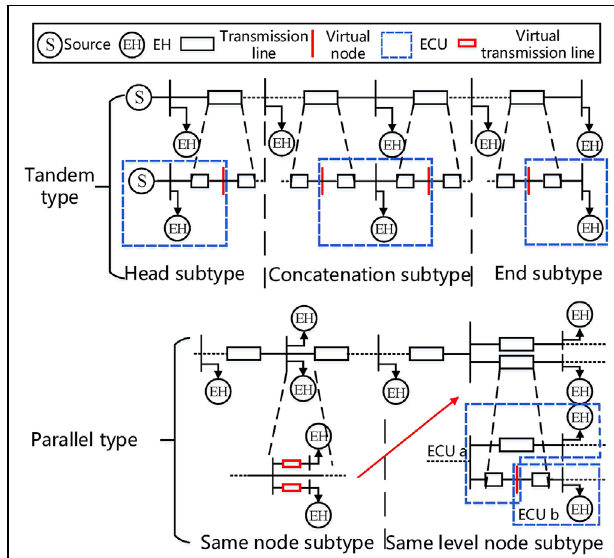
FIGURE 3 | Network partition